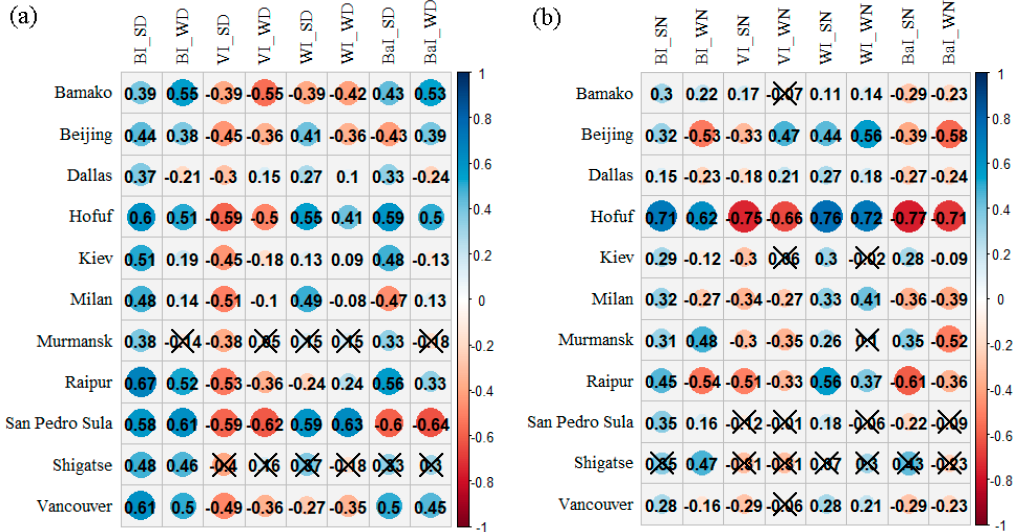
Figure 4. Spearman correlation coefficients and significance levels between land surface temperatures and indices of building, vegetation, water body and bare soil in eleven cities in typical global climatic zones during the daytime ( a ) and nighttime ( b ) in the summer and winter. These optimal remote-sensing indices were determined based on Table 4. BI, VI, WI and BaI represent the index of building, vegetation, water and bare soil, respectively. SD, WD, SN and WN refer to the summer daytime, winter daytime, summer night and winter night, respectively. The symbol “×” represents the fact that the partial correlation coefficients have not passed the significance level of 0.05.